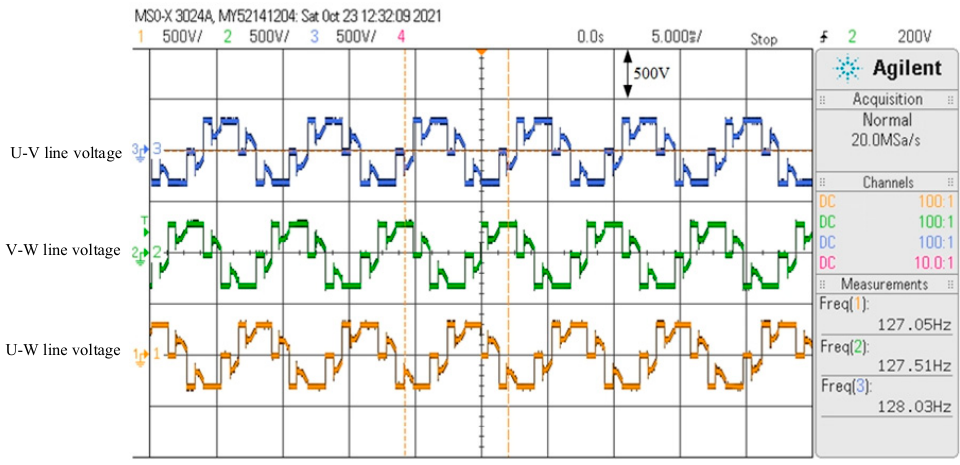
Figure 22. Output line voltage waveform of the commercially available drive at rotational speed frequency command of 150 Hz.